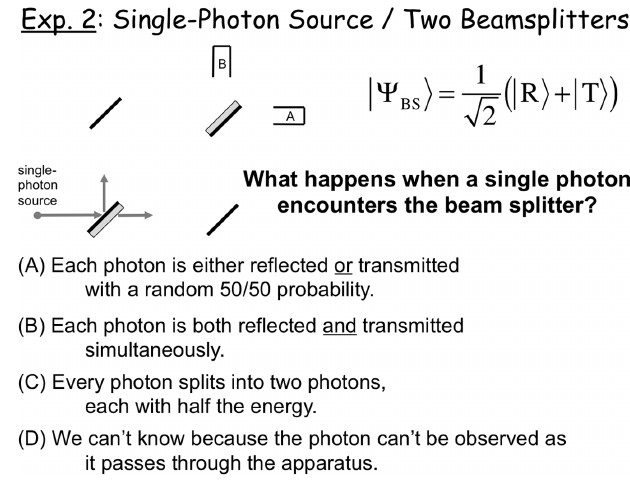
FIG. 8. Clicker question involving a Mach-Zehnder interfer- ometer with a single-photon source, used during lecture to generate in-class discussion about physically interpreting exper- imental data and mathematical